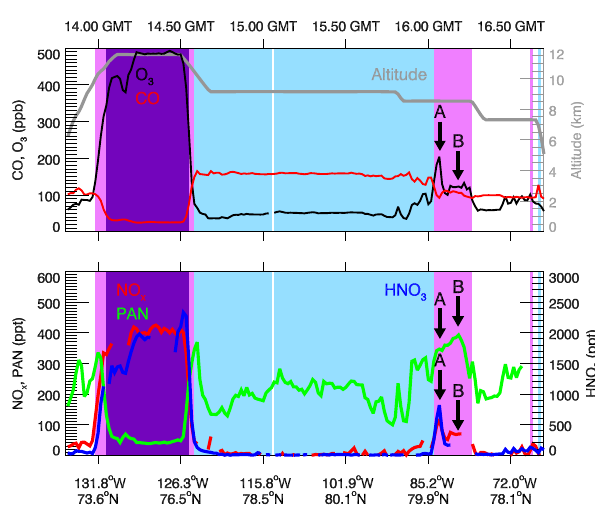
Fig. 8. Same as Fig. 7 but for DC-8 flight on 8 July 2008. Similarly, we highlight the identified air masses in color shad- ing: anthropogenic plumes (light blue), stratospheric air (purple), stratosphere-troposphere mixed air (lilac). The thick black arrows near 16:00GMT indicate the two sub-plumes ( A and B ) within the same stratosphere-troposphere mixed air mass (Sect.